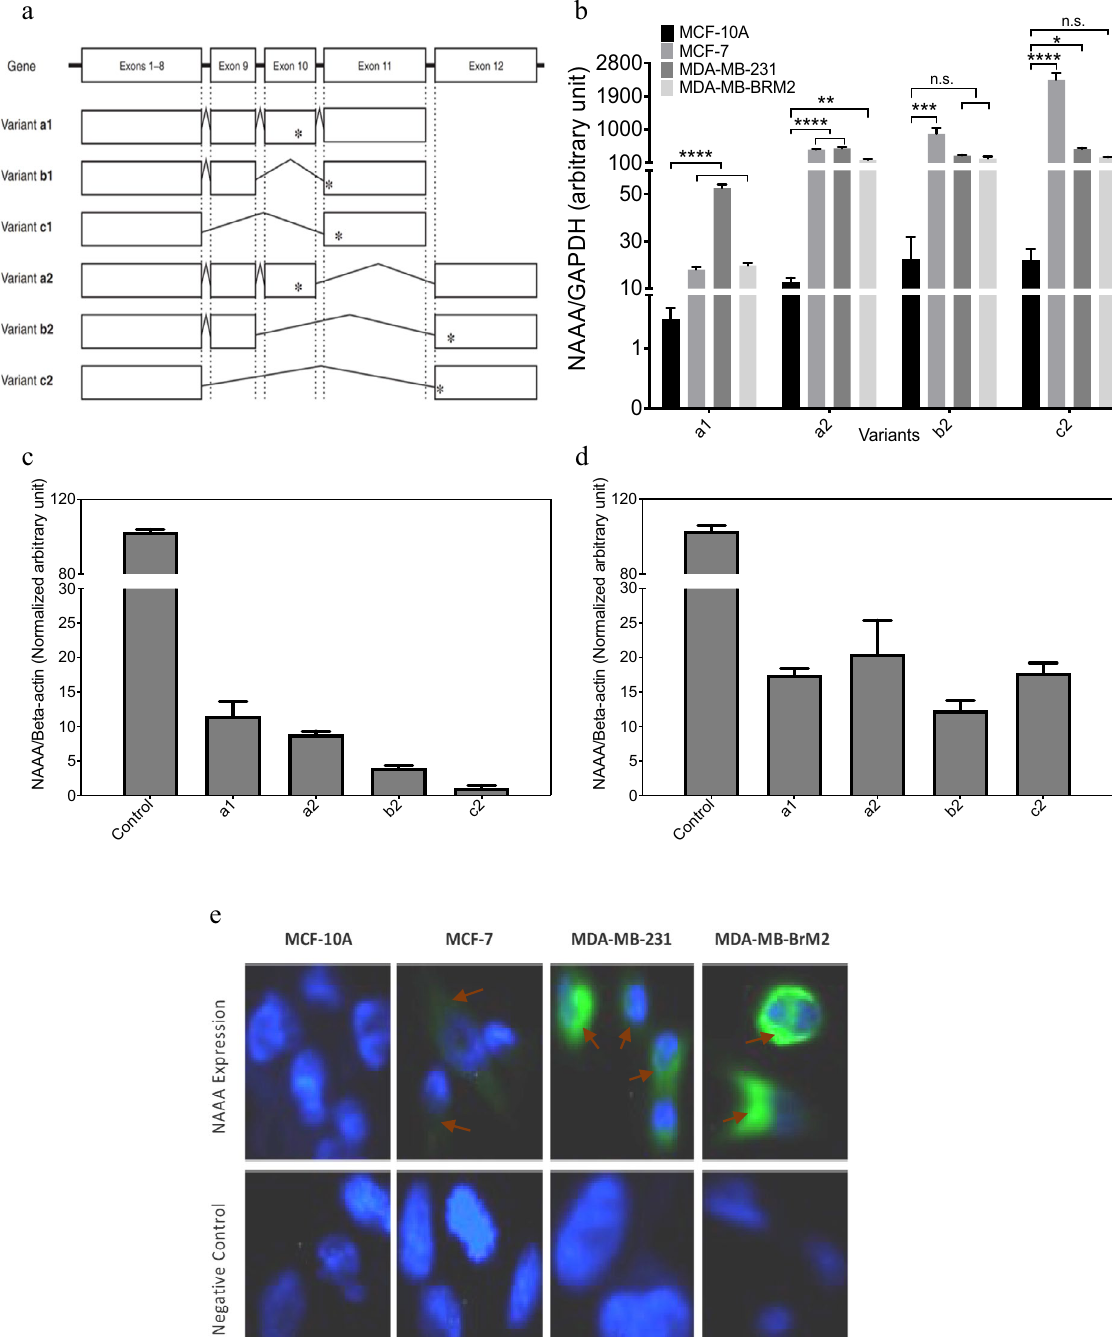
Figure 1. NAAA slice variants gene and protein Expression using qPCR and Immunofluorescence. ( a ) Schematic representation of NAAA splice variants and the sequences of PCR primers for NAAA were used as described in methods and elsewhere 35 . ( b ) qPCR results of the main variants of NAAA mRNA expression in MCF10A, MCF7, MDA-MB-231 and MDA-MB-BrM2 cells. The results are normalized to the levels of GAPDH mRNA expression. Values are expressed as means ± S. D (n = 3). ( c ) Expression of NAAA gene variants in siRNA treated MDA-MB-231 cells. The results are normalized to the levels of GAPDH mRNA expression. Values are expressed as means ± S. D (n = 3). ( d ) Expression of NAAA gene variants in siRNA treated MCF-7 cells. The results are normalized to the levels of GAPDH mRNA expression. Values are expressed as means ± S. D (n = 3). ( e ) Immuno-Fluorescence staining showing NAAA protein expression (Green color) and DAPI nucleus staining in blue. Isotype antibody was used for negative